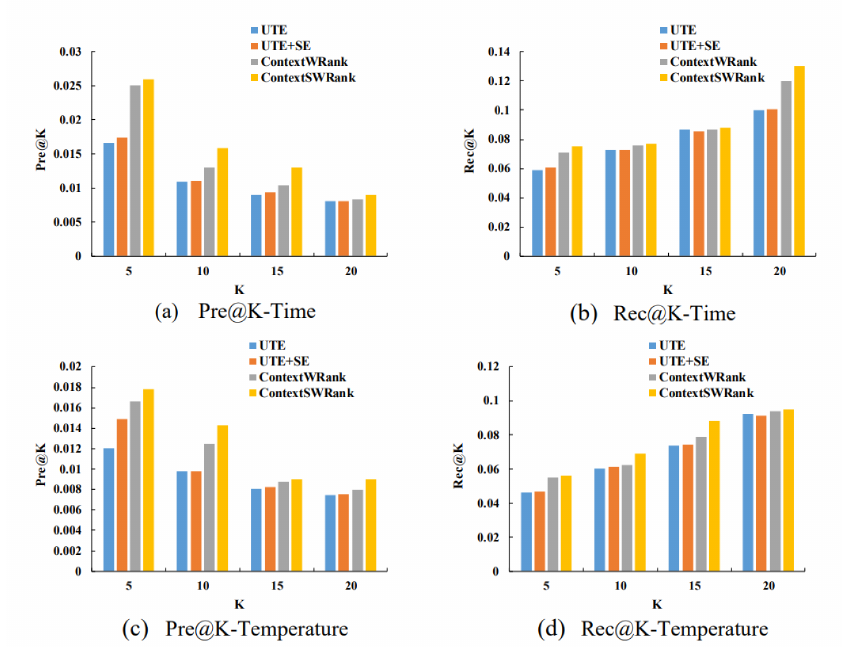
Figure 5. Performance comparisons of different methods considering time and weather contexts.